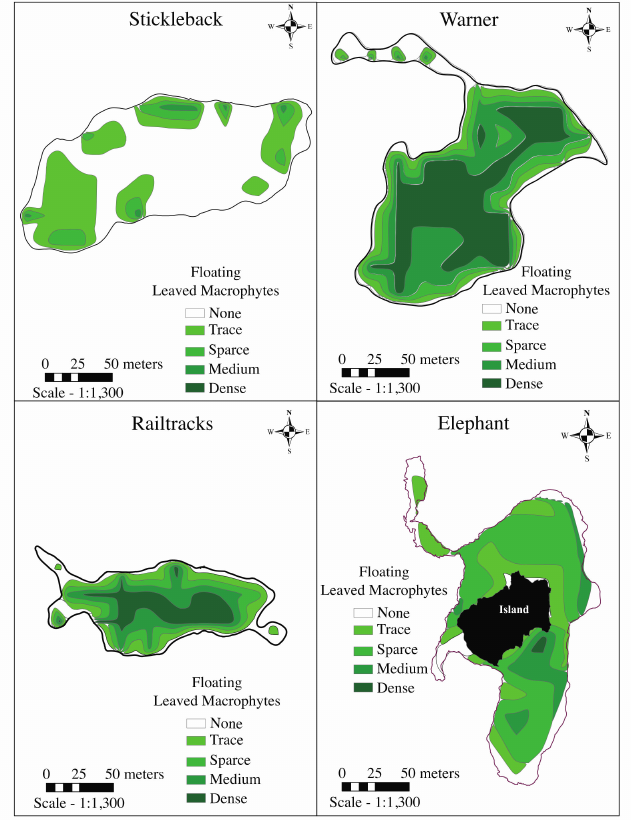
Figure 3. Maps of the extent of floating-leaved macrophytes in four ponds in east-central Minnesota,